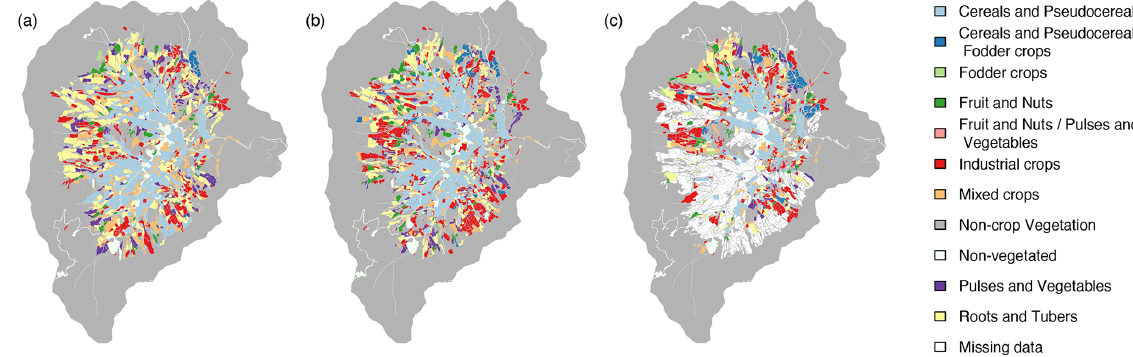
Figure 4. Crop types according to the FAO-LCCS in (a) 2009, (b) 2010 and (c) 2011.